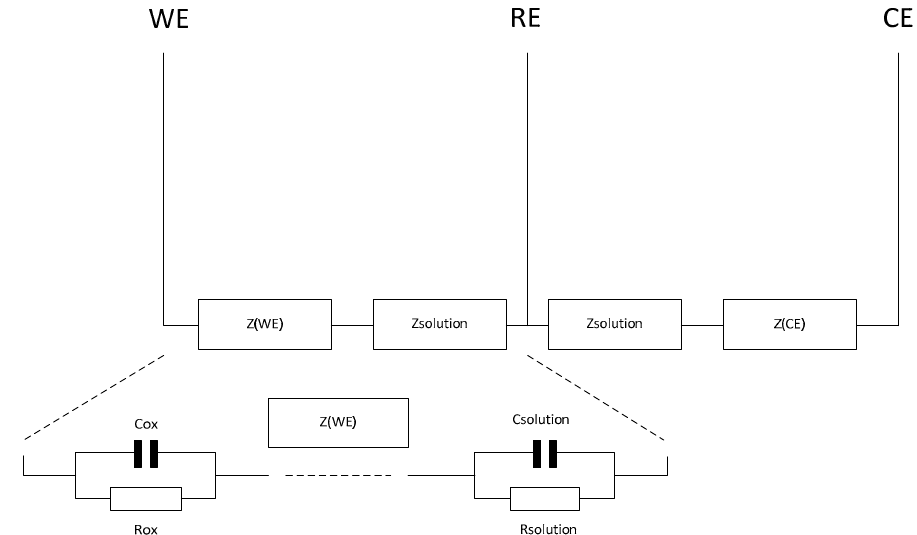
Figure 8. High frequency impedance is related to the oxide layer impedance and solution impedance (=solution resistance + solution capacitance).